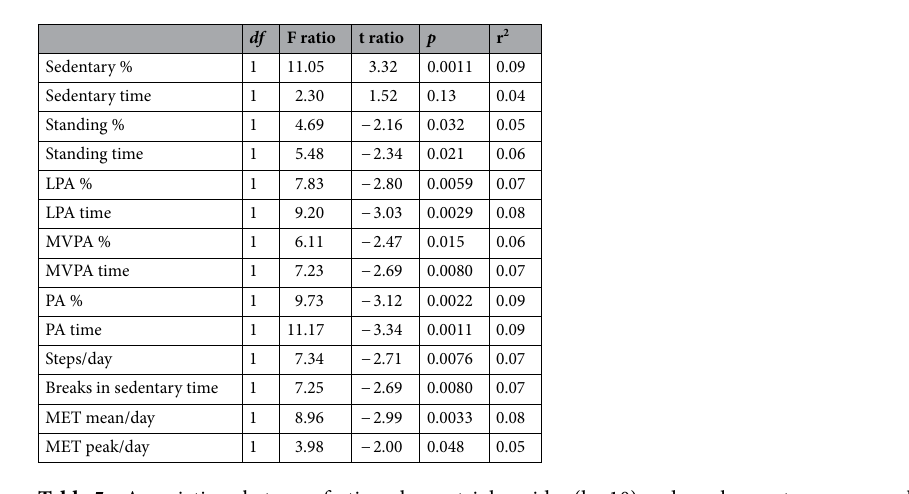
Table 5. Associations between fasting plasma triglycerides (log10) and accelerometer measures, least squares effect tests with sex, age and cholesterol lowering medication included in the model. LPA light physical activity, MVPA moderate to vigorous physical activity, PA physical activity (LPA and MVPA together), MET the metabolic equivalent.